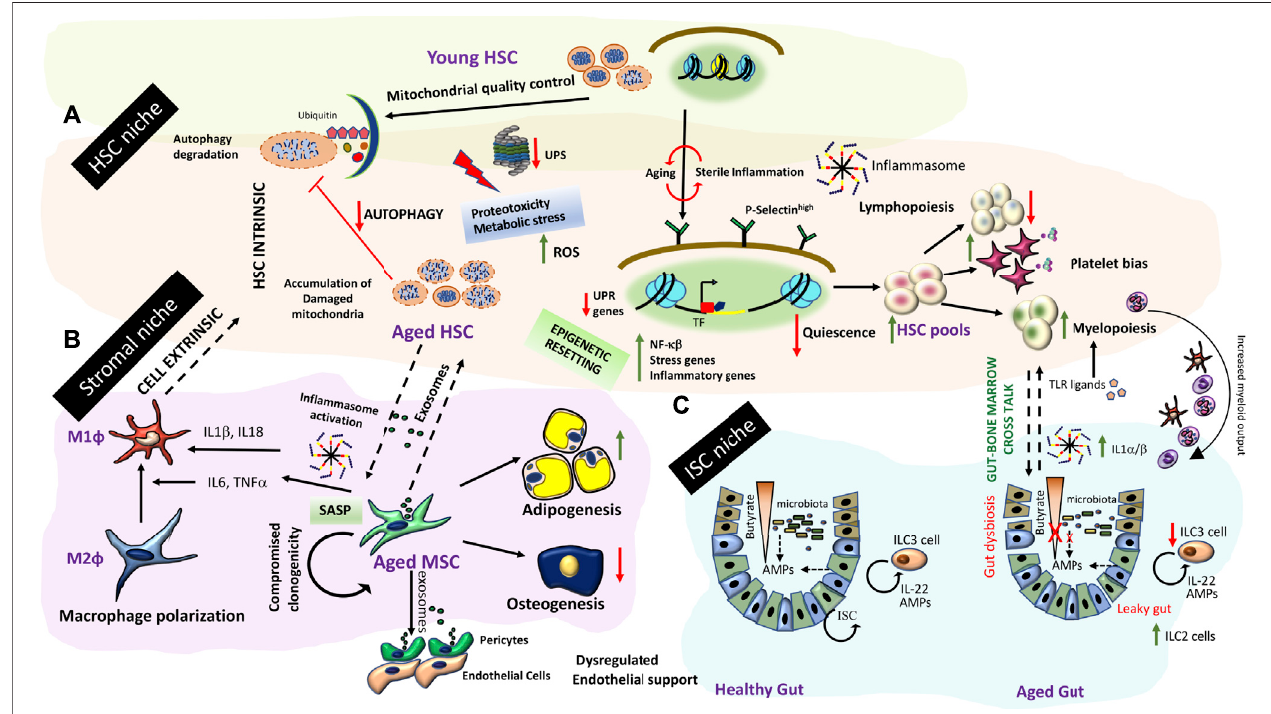
FIGURE 4 | In fl amm-aging and tissue niche homeostasis (A) In fl amm-aging of the bone marrow niche involves HSC intrinsic aging mechanisms (dysregulation of protein degradation, accumulation of effete organelles and broad epigenetic resetting) concomitant with HSC exhaustion and a predominant myeloid bias further driven byothernichedependentmechanisms (B) StromalcomponentssuchasMSCsexhibitaSASP.SecretomefromagedMSCs/stromalcomponentsdrivespolarizationto pro-in fl ammatory macrophages, and result in changes in HSC pools. Further stromal progenitor cells are more adipogenic and do not adequately support endothelialfunctionsresultinginbonemarrowendothelialandstromalnichealterationsaffecting HSCoutput. (C) Gut-bonemarrowcrosstalkinin fl amm-aging.Agingis associated with a leaky gut causing gut dysbiosis and an iterative in fl ammation sequelae impacting ISC renewal and exposure of TLR ligands in the circulation. An enhanced demand for myeloid output along with in fl ammasome generated IL-1 α / β exaggerates myeloid biased differentiation from HSCs in the bone marrow.